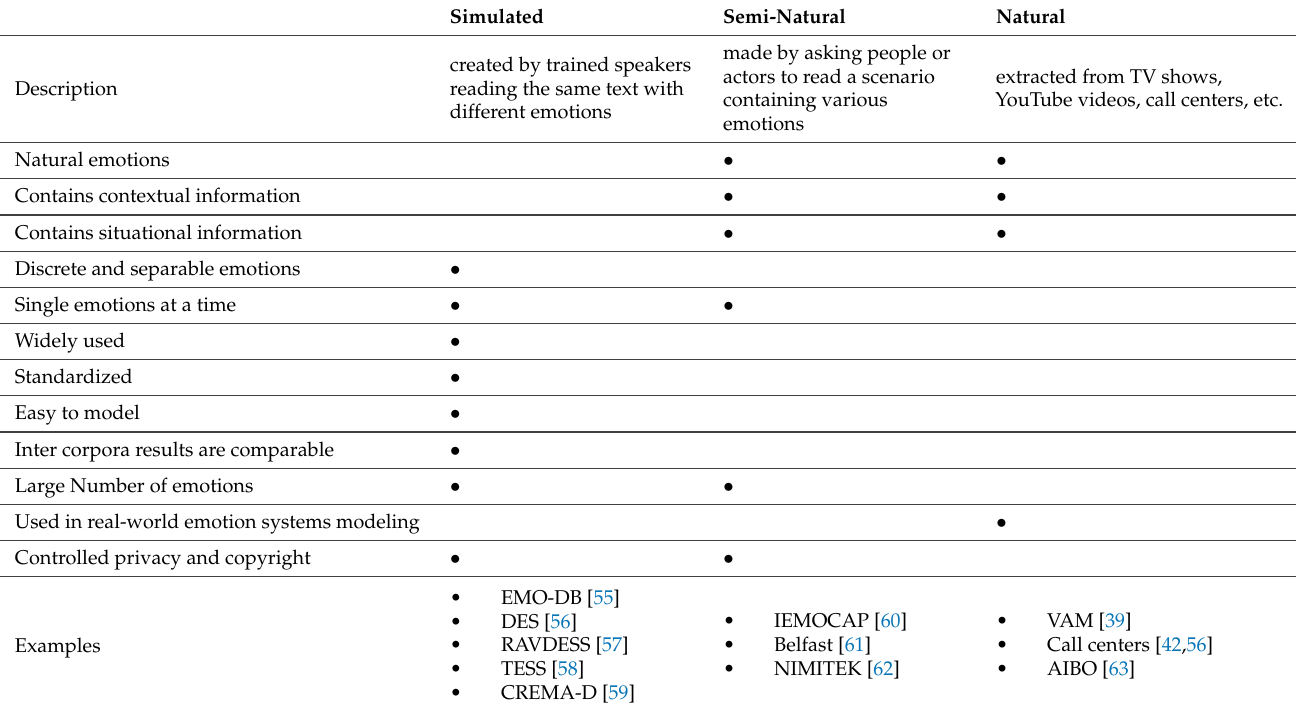
Table 1. Categories of emotional speech databases, their features, and some examples of each category. A black dot ( • ) means having a